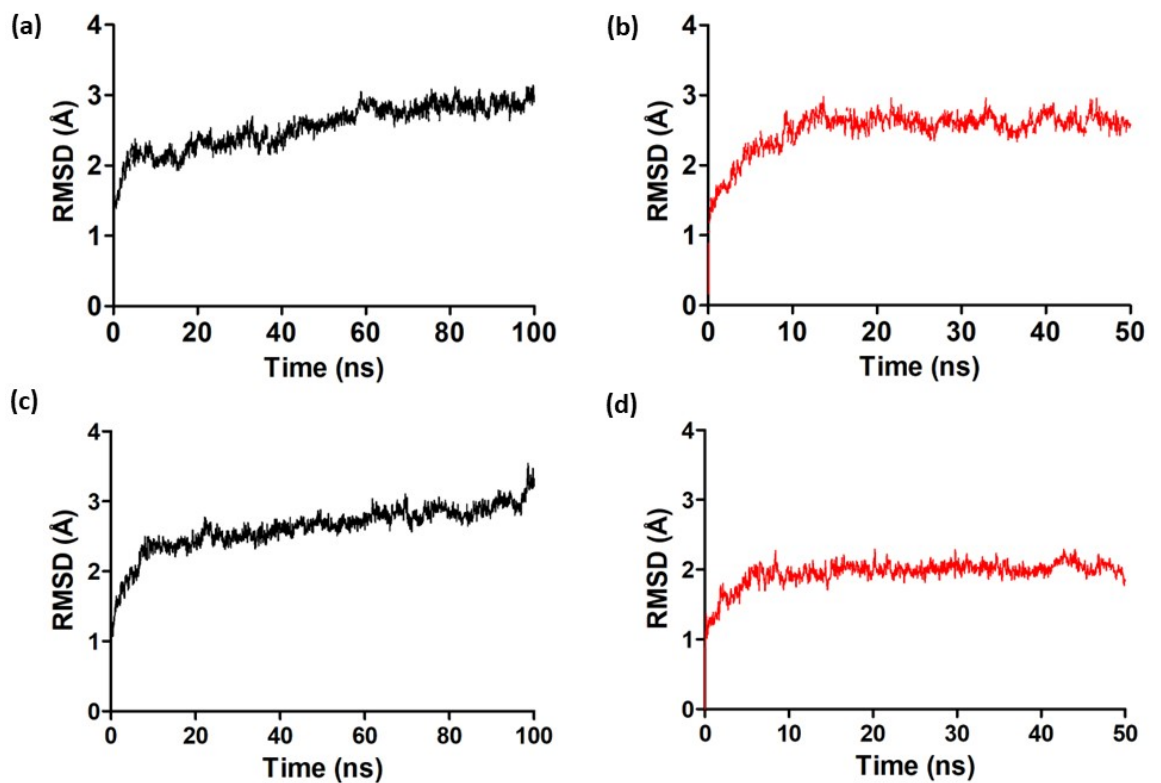
Figure 5. RMSD (backbone) of the APO structures and AChE and BuChE complexed with ZINC390718 during molecular dynamics of 100 ns (APO forms) and 50 ns (complexed forms). ( a ) AChE APO form; ( b ) AChE complexed with ZINC390718; ( c ) BuChE APO form; ( d ) BuChE complexed with ZINC390718.